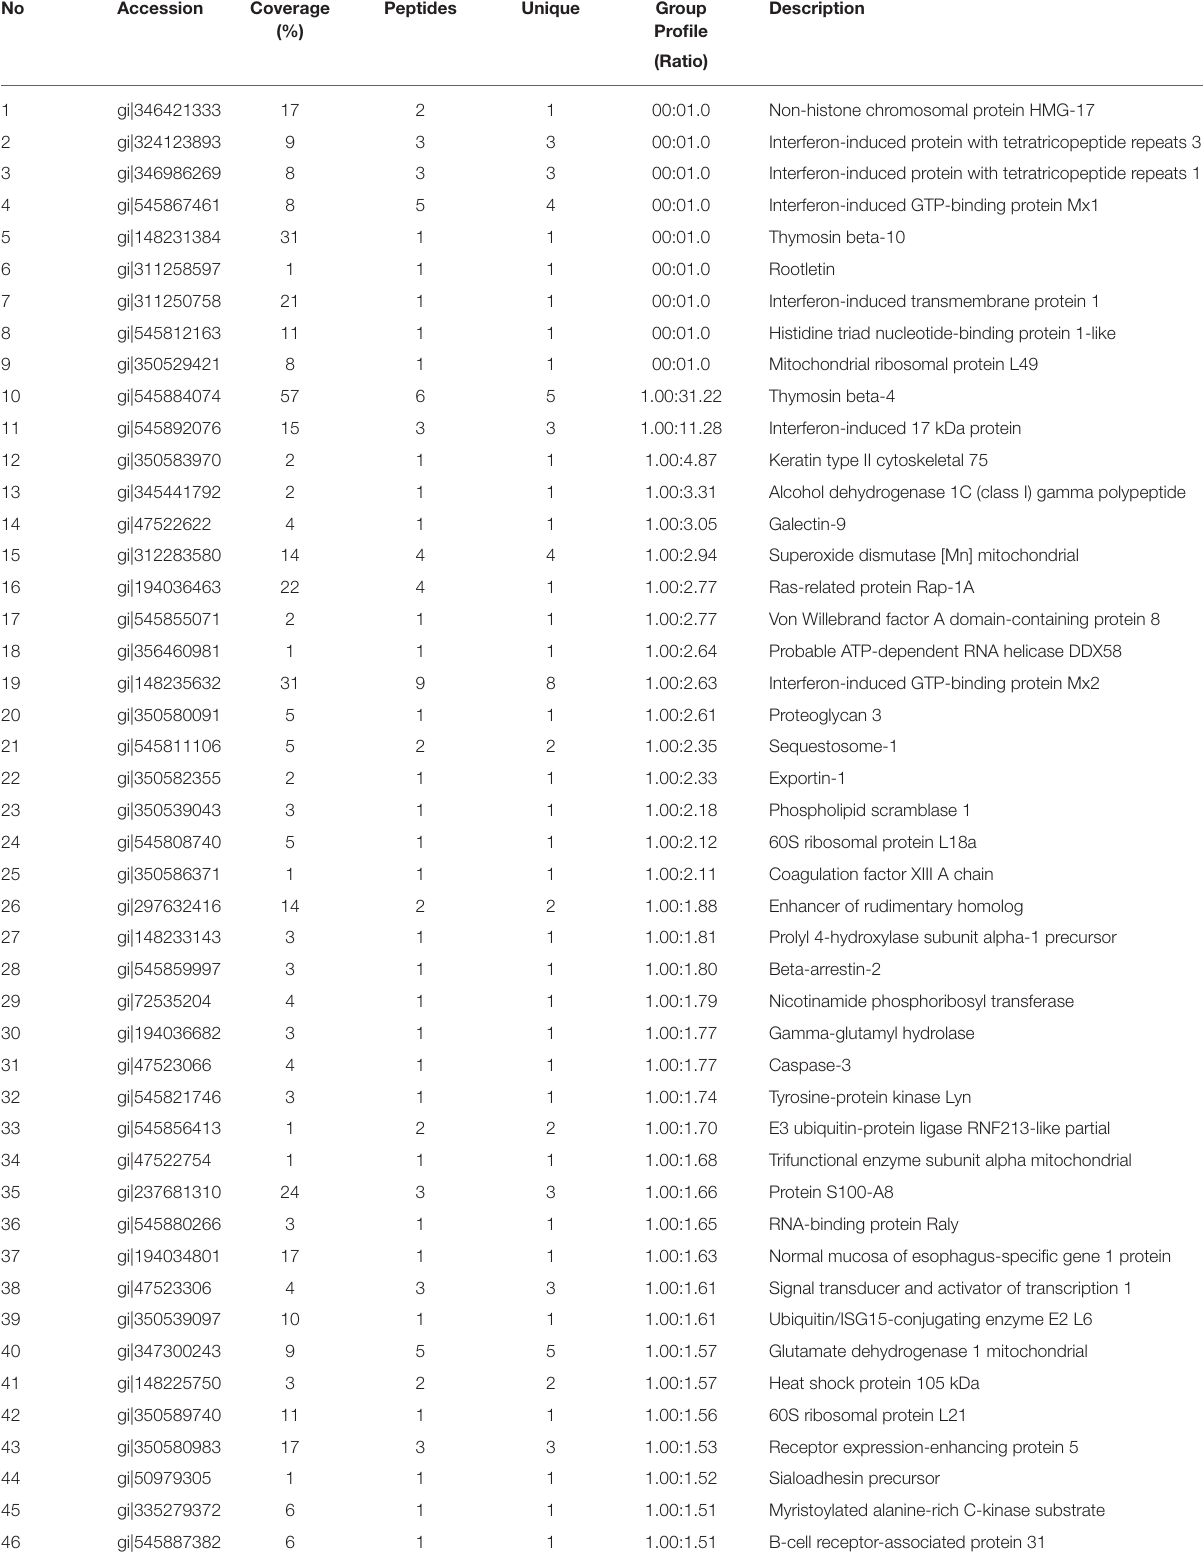
TABLE 1 | The significantly up-regulated proteins in HP-PRRSV HN07-1-infected PAMs identified by